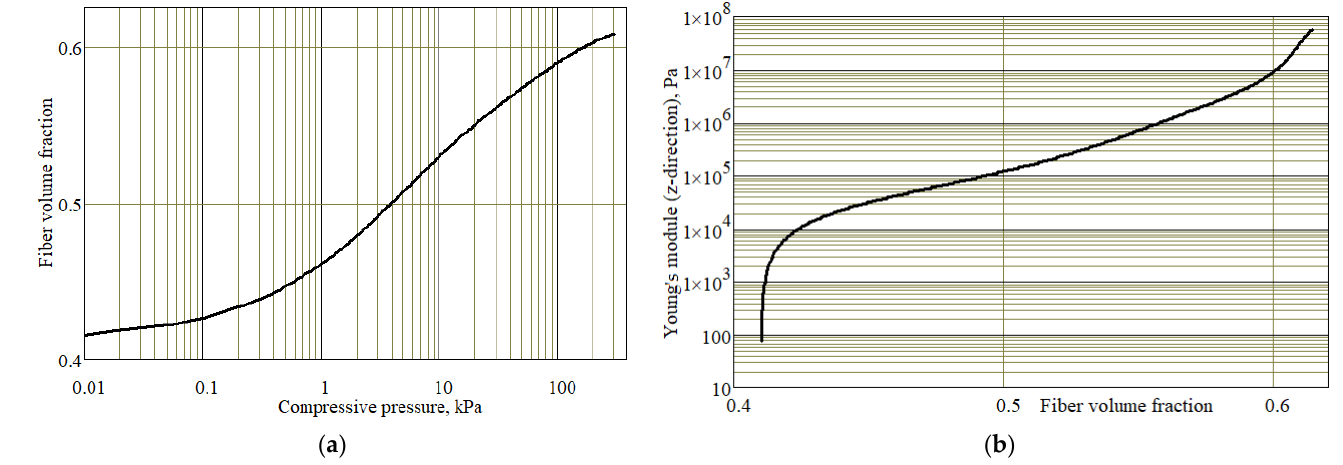
Figure 1. Compressive properties of the modeled wet preform: ( a ) Dependence of the fiber volume fraction on the compressive pressure; ( b ) Dependence of the Young’s modulus in z-direction on the fiber volume fraction.